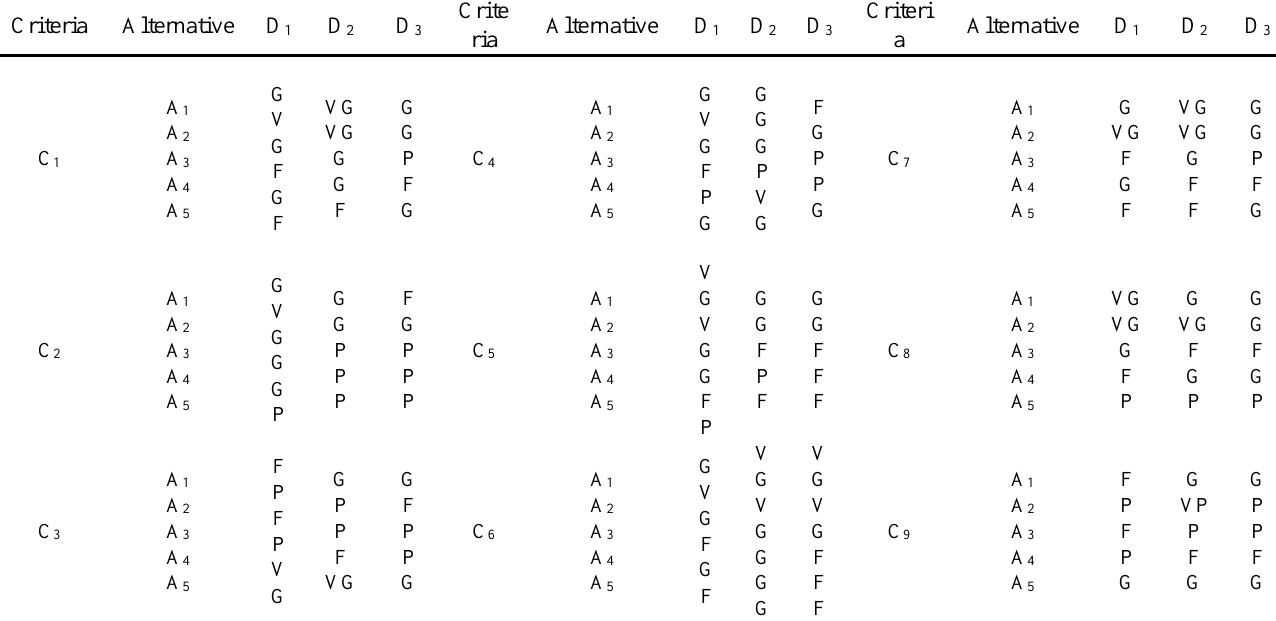
Table 4. Linguistic assessments for the five alternatives .